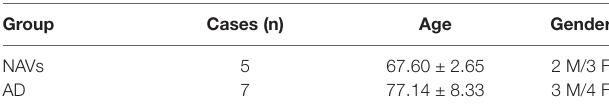
TABLE 1 | Clinical data of AD patients compared to normal age-matched volunteers (NAVs).